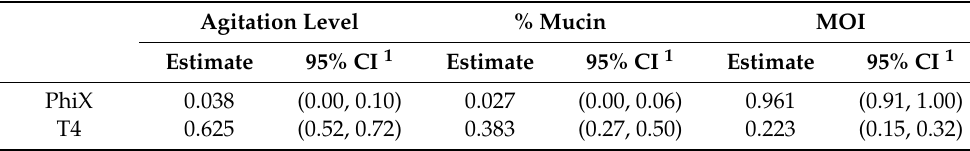
Table 7. Estimated total sensitivity scores for each experimental